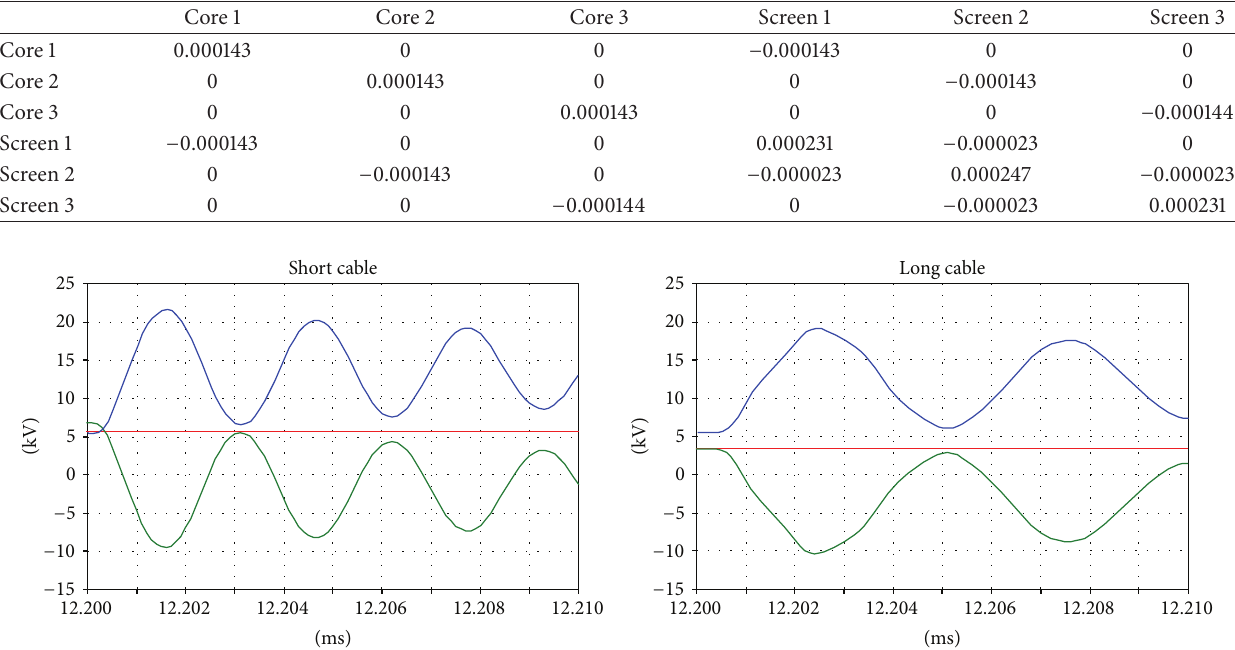
Figure 15: Primary side voltages: the transient oscillation frequency during the inrush.